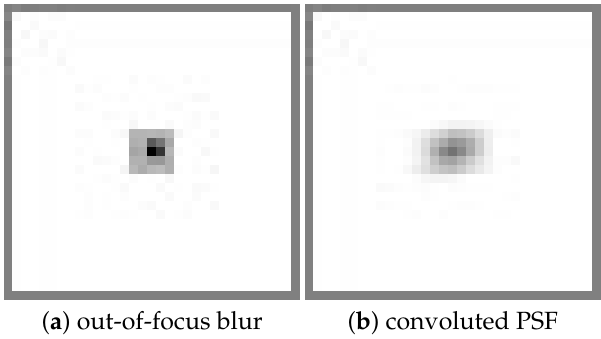
Figure 14. Creation of F × F convoluted PSF.